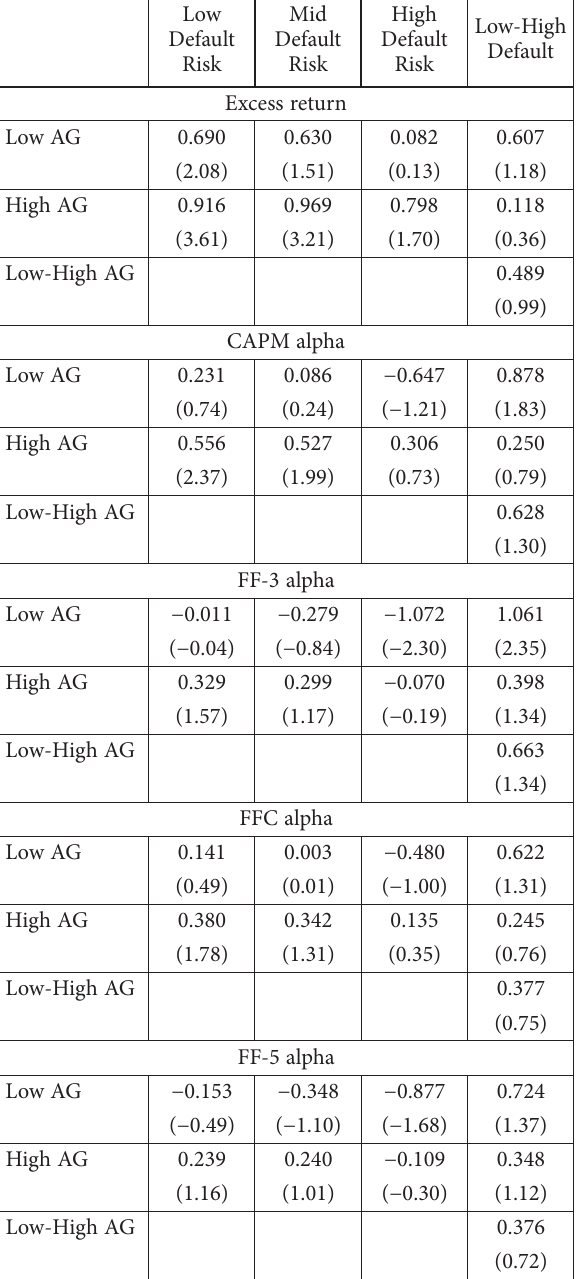
Table 5. Default risk premium and asset growth